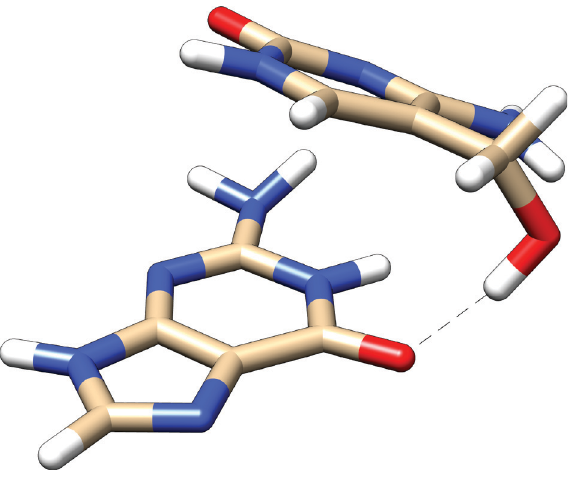
Figure S1. Optimised geometry of stacked 5-hC…G, showing the hydrogen bond to the O6 atom of G. Cartesian coordinates of all optimised structures from this work are provided in the data